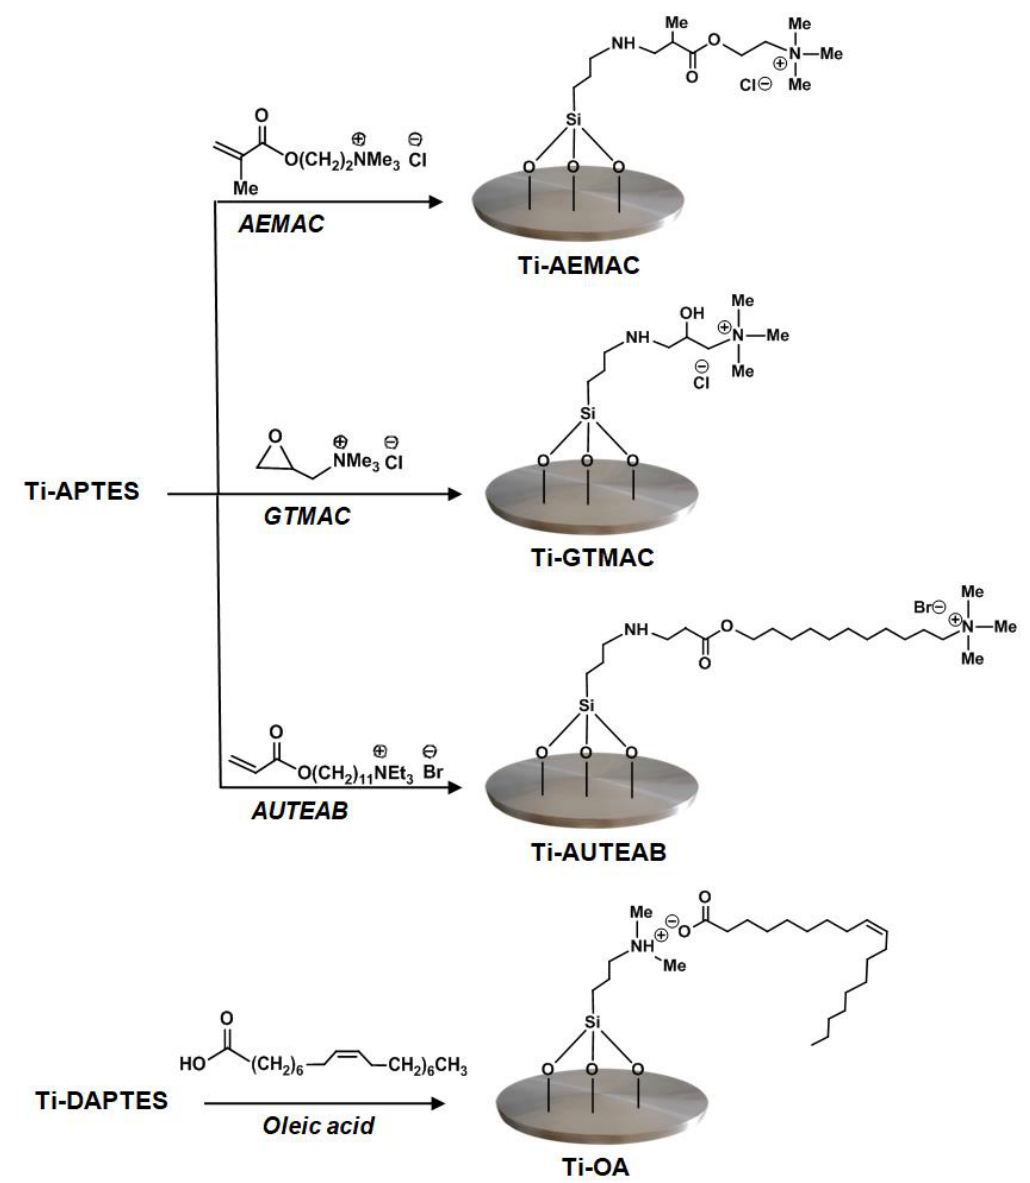
Figure 5. Schematic diagram illustrating the synthetic routes for titanium surface functionaliza- 279 tion. 280